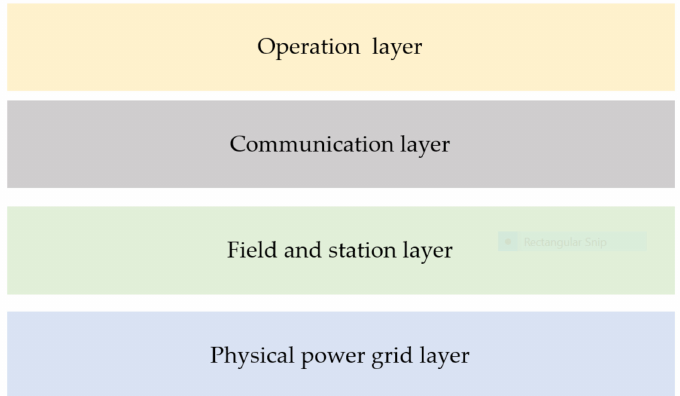
Figure 4. High level categorization of power grid assets for analysis of interview